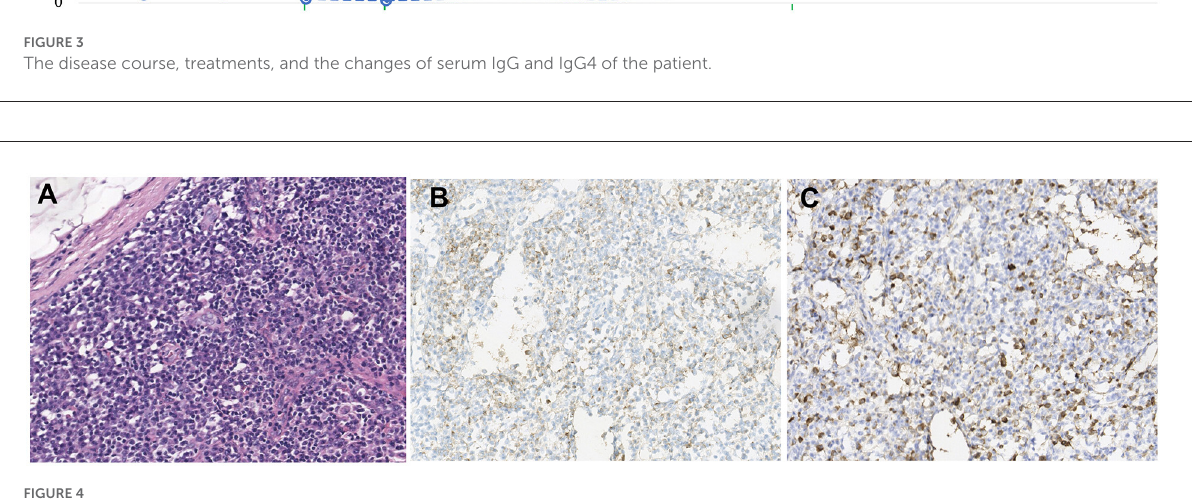
extensive, involving the corticospinal tract and corpus